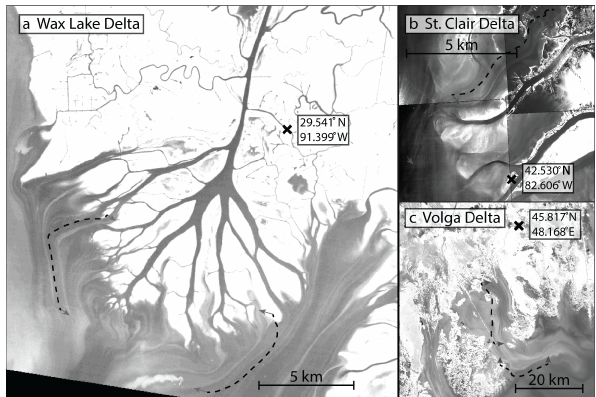
Figure 1. Images of river deltas exhibiting streak lines. (a) Wax Lake Delta (Landsat image LT50230402011002CHM01 band 4). (b) The Saint Clair Delta in Michigan, USA (dig- ital orthophoto quads, Saint Clair Flats NE, NW, SW, SE; IR band). (c) Portion of the Volga Delta in Russia (Landsat LC08_L1TP_168028_20170501_01 band 4). In each image, streak lines are mapped in dashed lines. The line is translated in space slightly (see gray arrows) so as not to cover the streak line in the